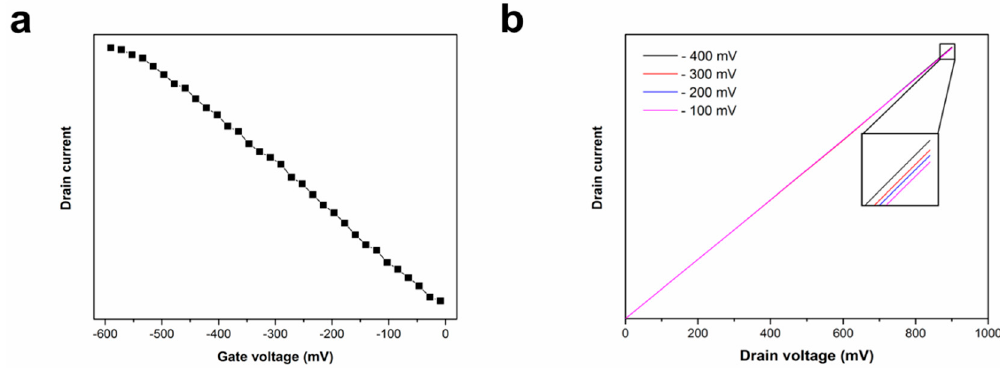
Figure 5. Atomic force microscopy image and the corresponding section analysis of horizontally aligned carbon nanotubes on quartz substrate.